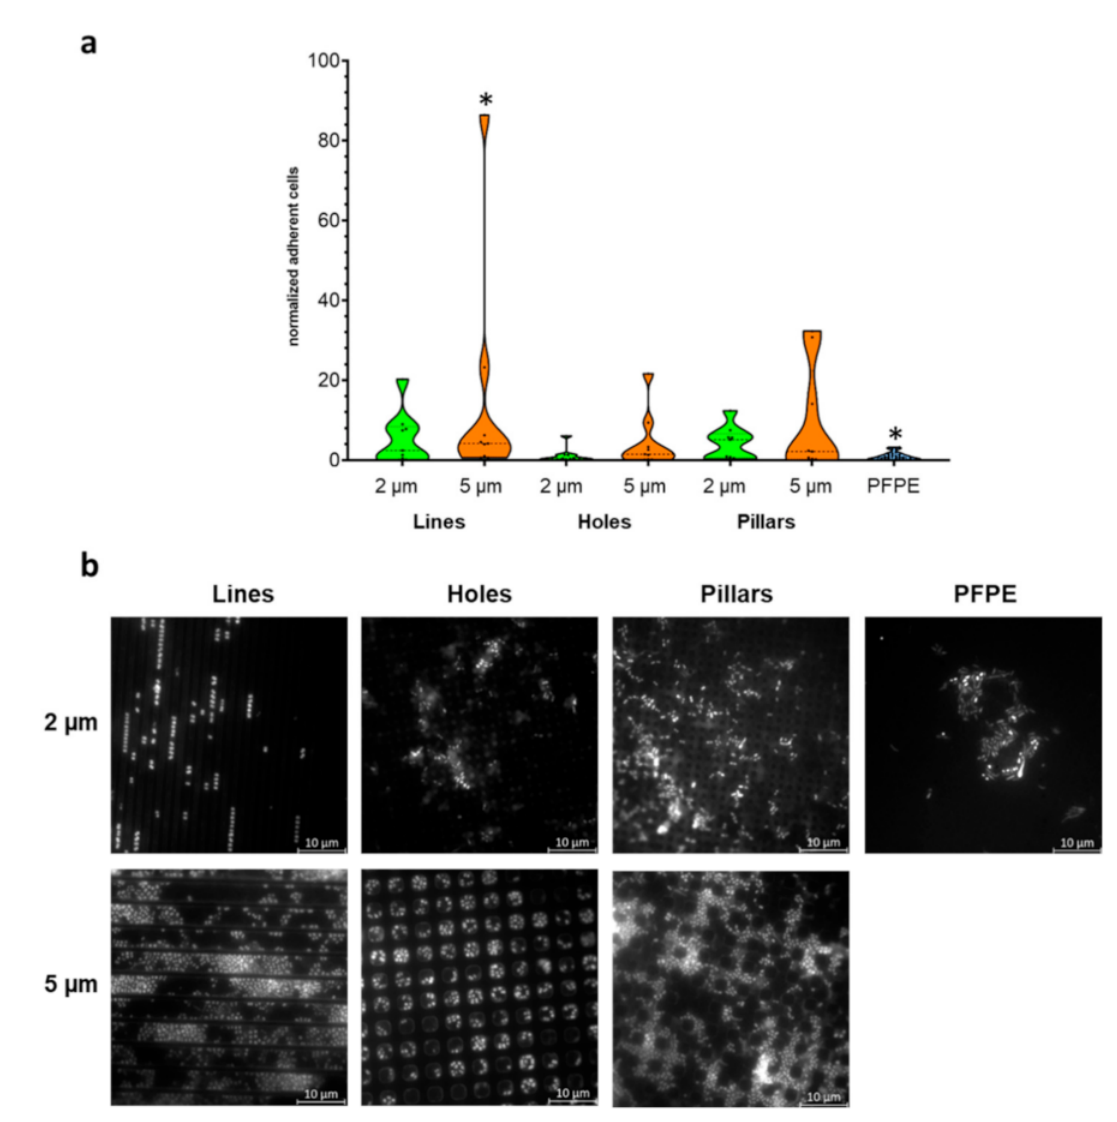
Figure 2. Adherence of microorganisms to micro-structured specimens. ( a ) Specimens made from PFPE containing microstructures of different geometries (lines, holes, or pillars) and dimensions (2 µ m or 5 µ m) as well as plain PFPE were exposed to the oral cavity for 8 h. Depicted is the number of adherent cells normalized to the adherence on plain PFPE. * p < 0.05 ( b ) Representative images of DAPI-stained specimens for the different structures and dimensions. Microorganisms are mostly detected within